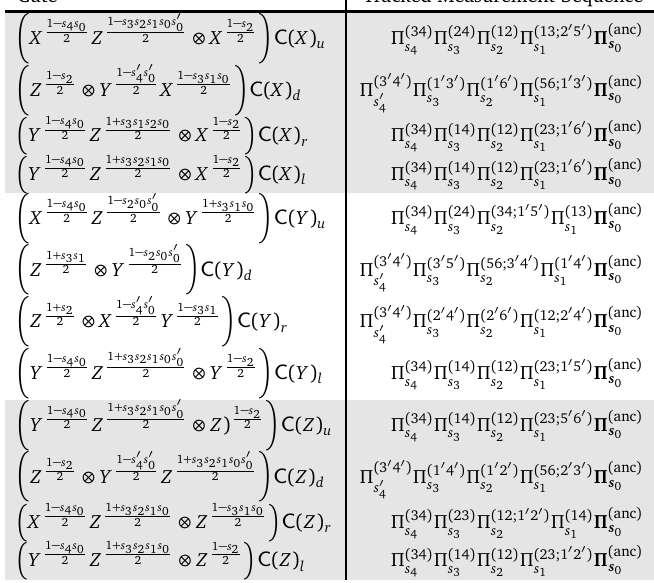
Table 26: Pauli gate corrections tracked for the corresponding controlled-Pauli gates implemented using Majorana-Pauli tracking methods. The implicit action 1 − s (cid:48) ns (cid:48) 0 1 − sns 0 Π ( 34 ) ⊗ X Π ( 3 (cid:48) 4 (cid:48) ) on the two ancillary qubits is X for sequences of length n . 2 2 s 0 s (cid:48) 0 (When there is not a final projector for one of the ancillary pairs, it is equivalent to there being a projector for that ancillary pair onto its initial projection channel, = s = s (cid:48) e.g. s or s (cid:48) .) n 0 n 0 Gate Tracked Measurement Sequence